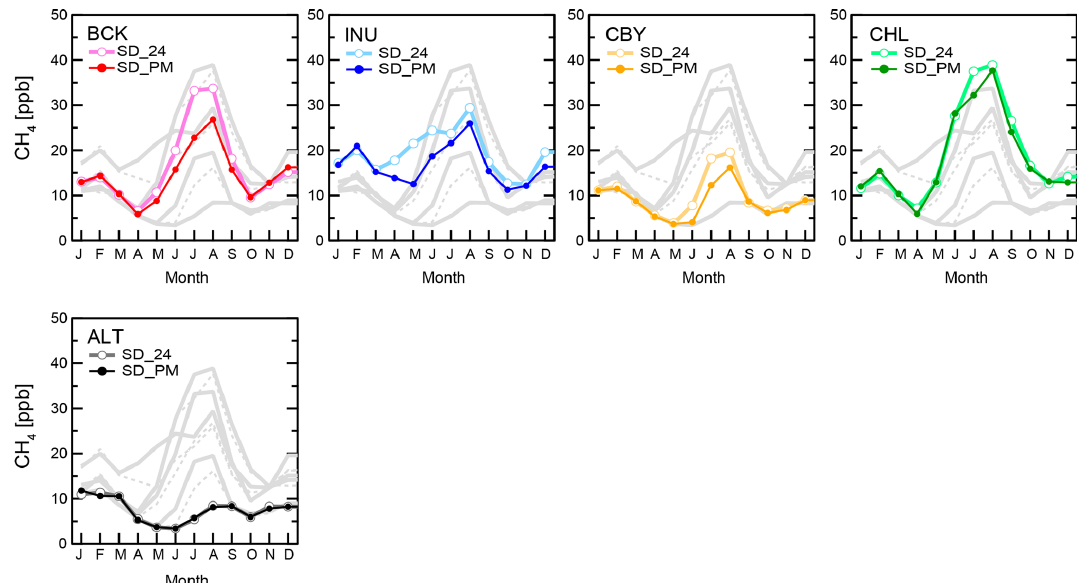
Figure 4. Mean seasonal cycles of monthly standard deviation (SD) of observed CH 4 mixing ratios, SD_24 of all 24-hourly data (closed circles), and SD_PM of afternoon data (12:00–16:00 local time, open circles) to the fitted curves. For BCK, 2014 data have been excluded from the analysis because of high variability due to massive forest fires around the site.